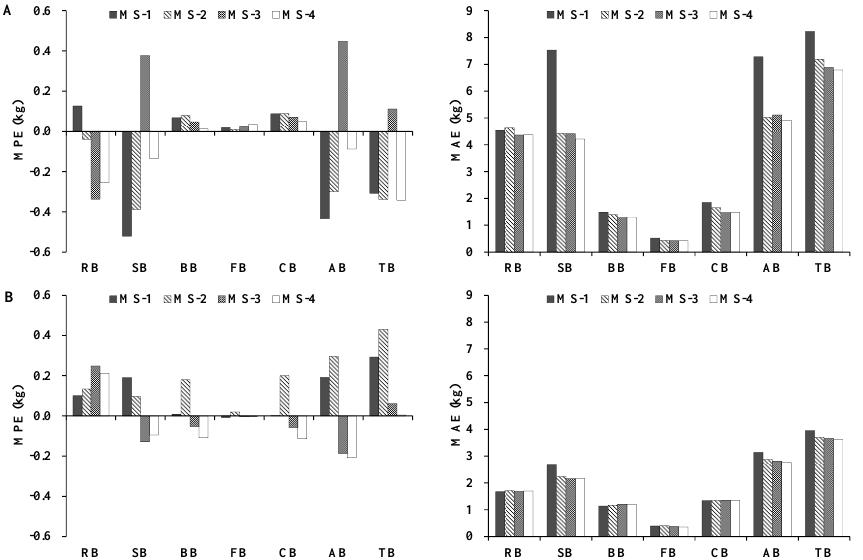
Figure 3. Mean prediction error (MPE) and mean absolute error (MAE) among the total, subtotal, and component biomass for ( A ) Dahurian larch and ( B ) white birch, where RB, SB, BB, FB, CB, AB, and TB stand for root, stem, branch, foliage, crown, aboveground, and total biomass, respectively.